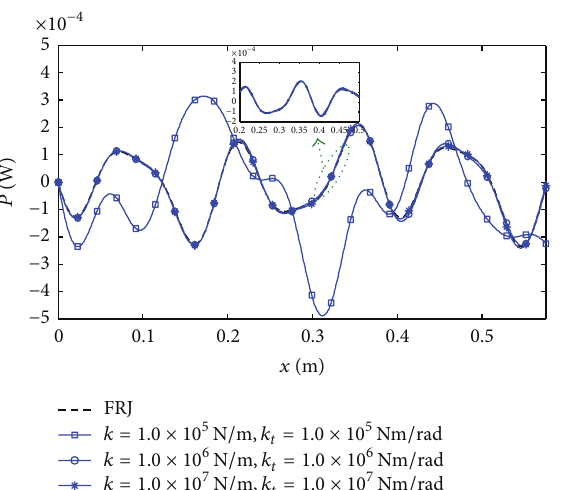
Figure8:VibrationpowerflowoftheFRMEJwithdifferentrestraint rigidities under the motion disturbance.